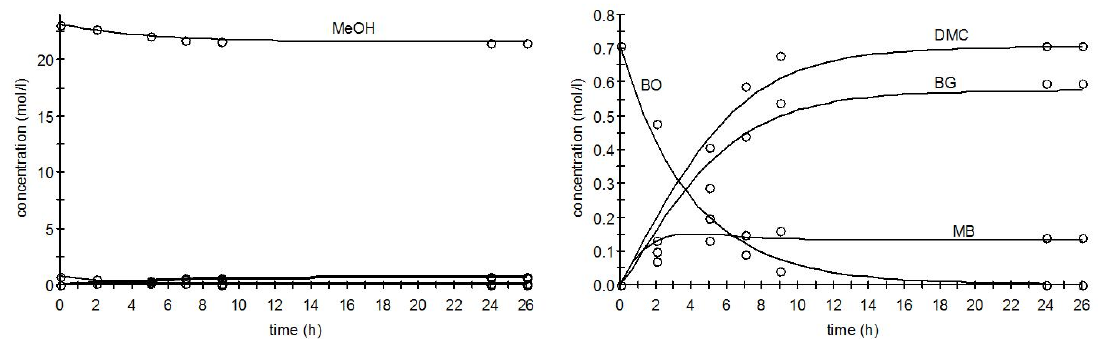
Figure 11. Performance of the solution of ordinary differential equations (ODEs) and parameter estimation method: synthesis of dimethyl carbonate (DMC) (150 °C, initial CO 2 pressure of 45 bar). The smaller concentrations in the left figure (butylene oxide (BO), DMC, butylene glycol (BG), methylene butylate (MB)) are magnified in the right figure.